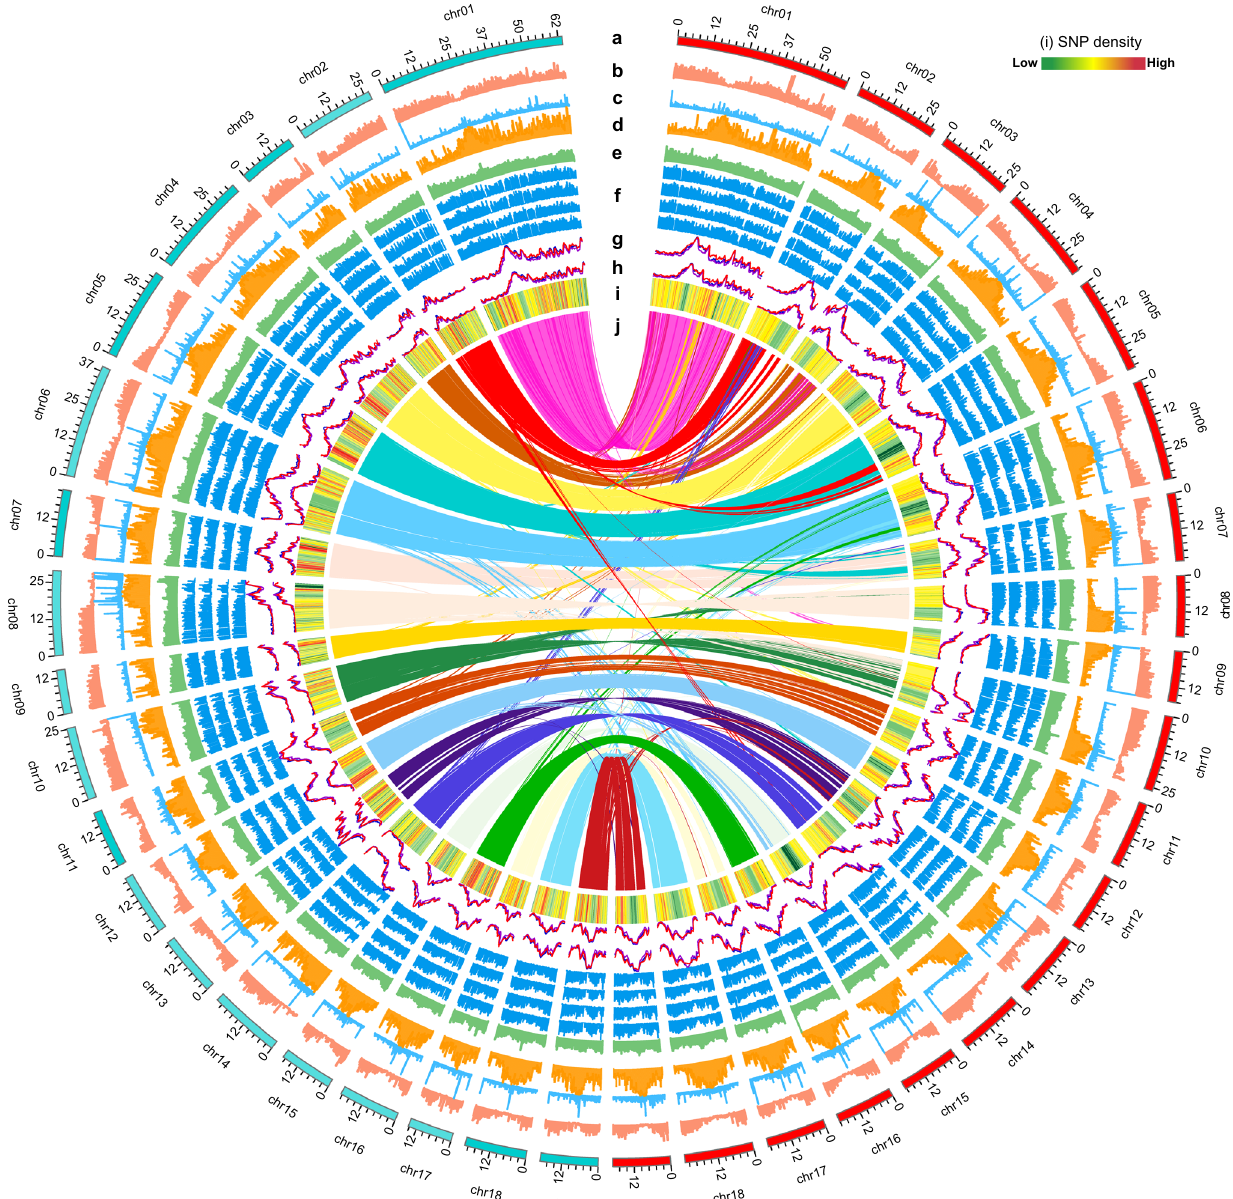
Fig. 1 Chromosomal-scale male and female P. euphratica genomes with the integration of diversity, expression, and methylation data. a Circular representation of 19 pseudomolecules from the male (cyan, left) and female (red, right) genomes. b – e Density of genes ( b ), tandem repeats ( c ), transposons ( d ), and GC contents ( e ). f Gene expression levels in catkins and leaves from female and male plants (from outer to inner tracks: female catkin, female leaf, male catkin, and male leaf). g , h DNA methylation levels in the CG (red), CHG (blue), and CHH (purple) contexts in young stems from female ( g ) and male ( h ) plants. i SNP density generated by BSA (color gradient key). j Syntenic relationships between the male and female